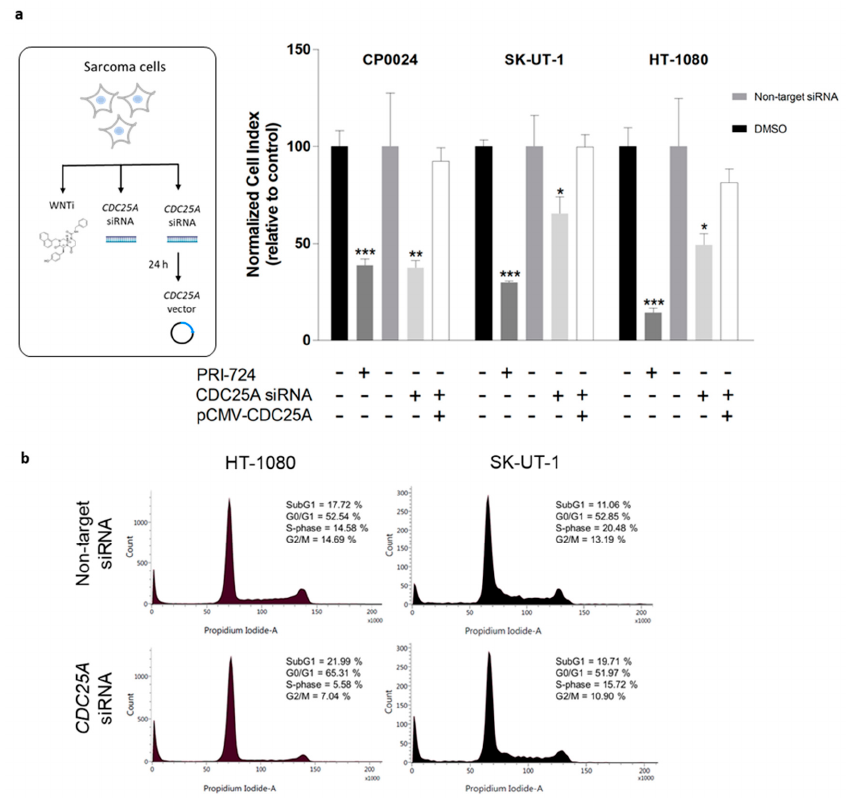
Figure 4. Depletion of CDC25A inhibits cell proliferation either via cell death induction or G1